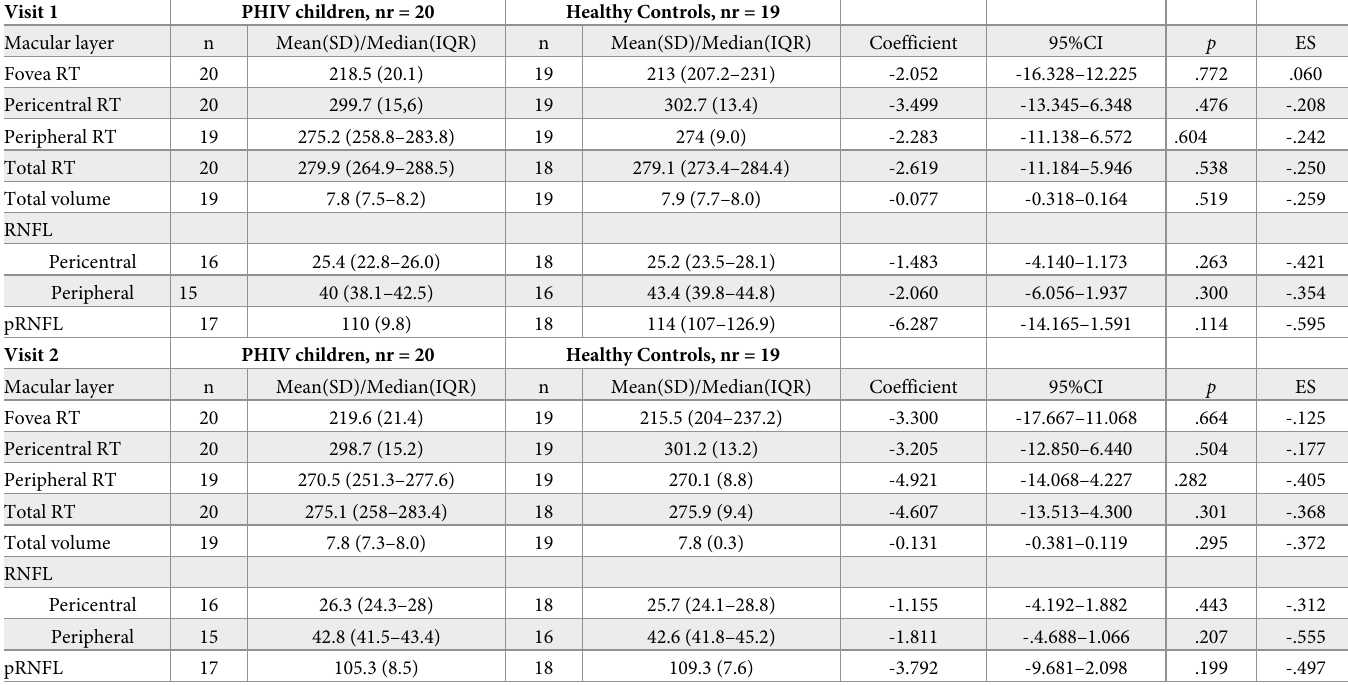
Table 2. a. OCT Individual Retina Layer Thickness in PHIV Children and Healthy Controls, longitudinal substudy visit 1. b. OCT Individual Retina Layer Thick- ness in PHIV Children and Healthy Controls, longitudinal substudy visit